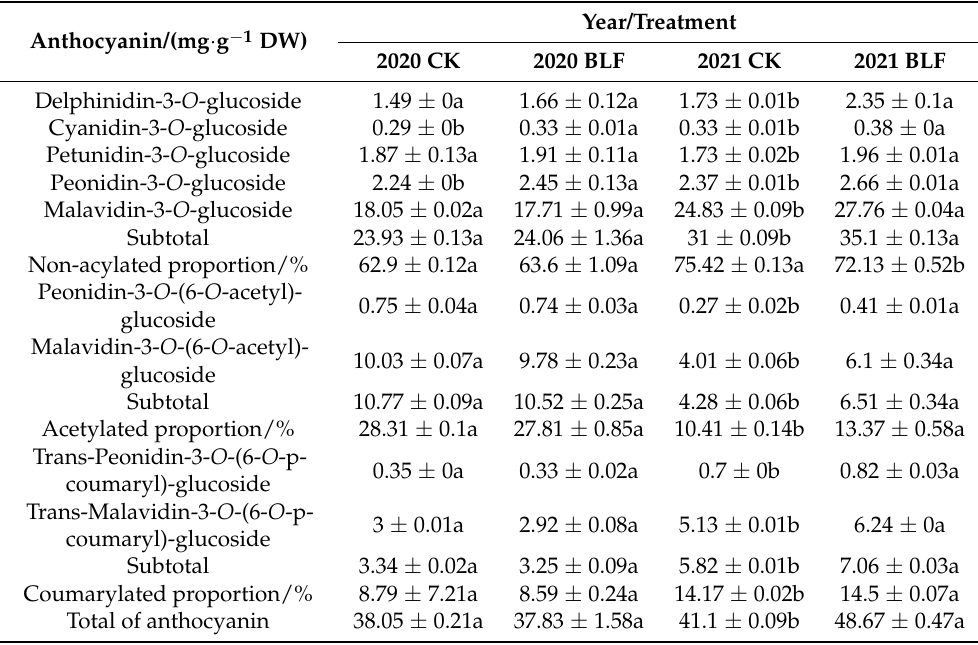
Table 4. Concentrations of monomeric anthocyanins in ‘Cabernet sauvignon’ grape skins from BLF and CK treatments in 2020 and